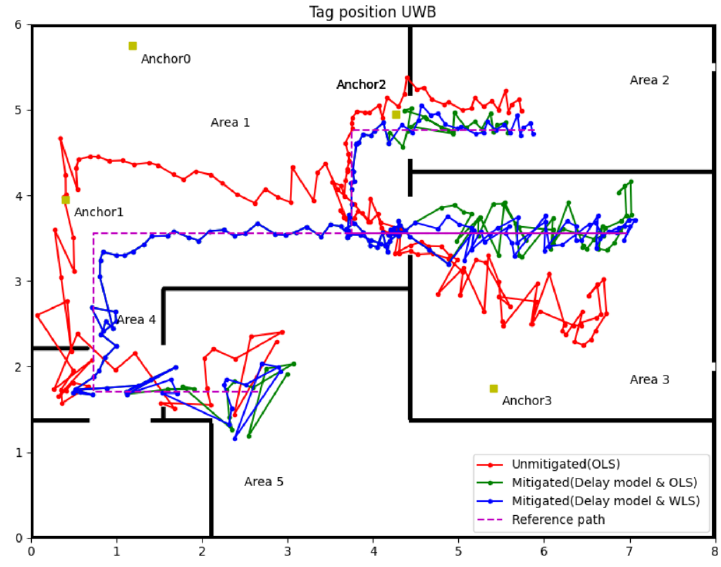
Figure 10. Relationship between θ and the W θ .